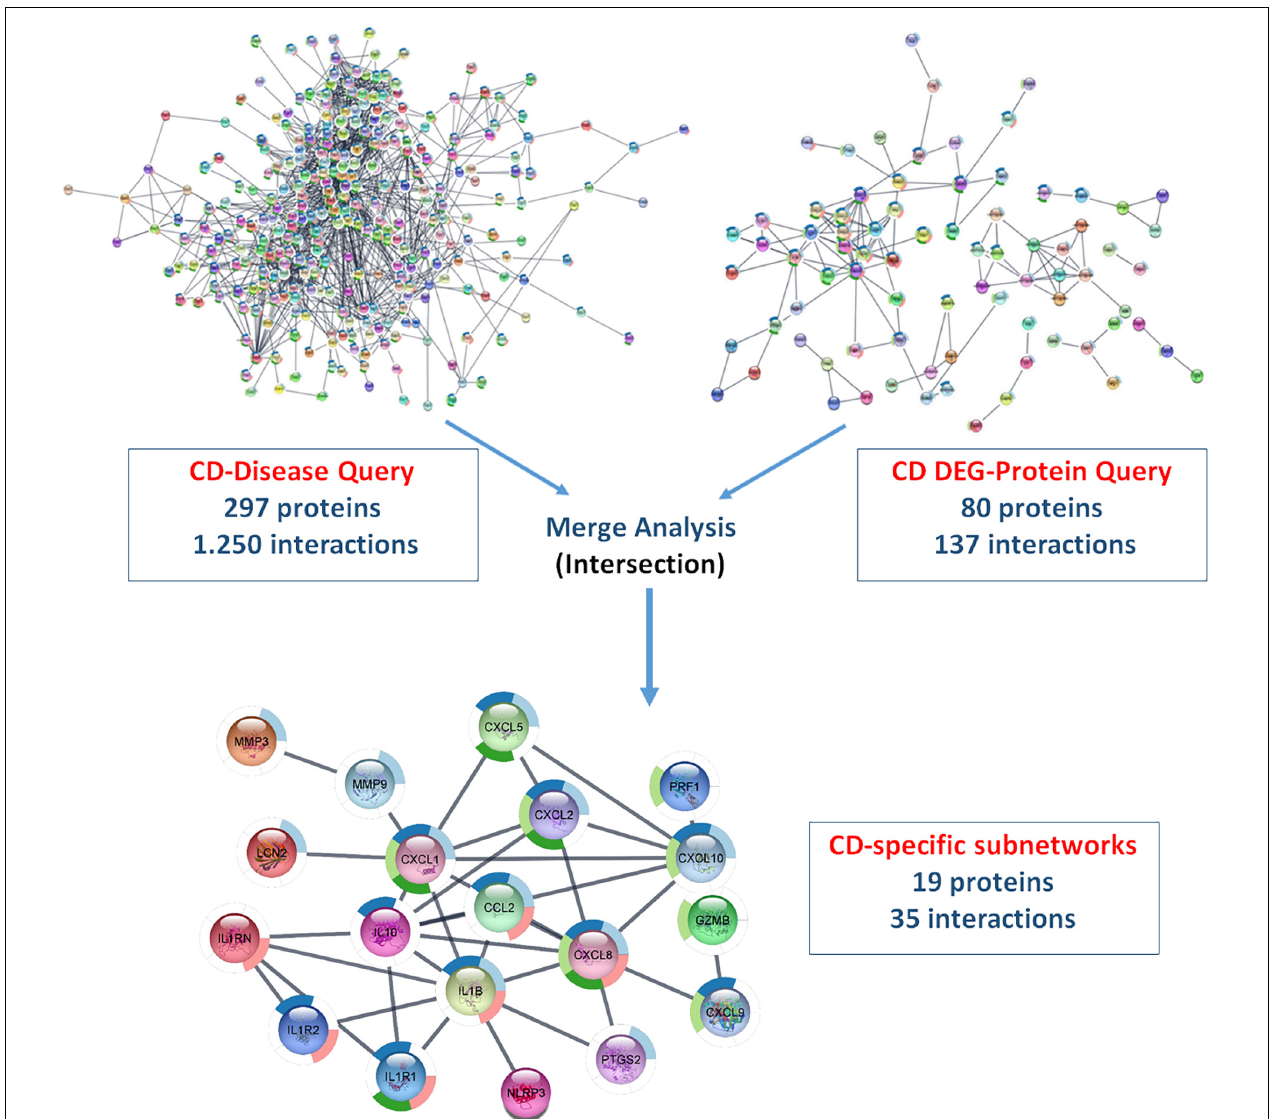
FIGURE 6 | Analyzing disease- and DEG-specific PPI networks for the discovery of a CD-specific subnetwork with StringApp.